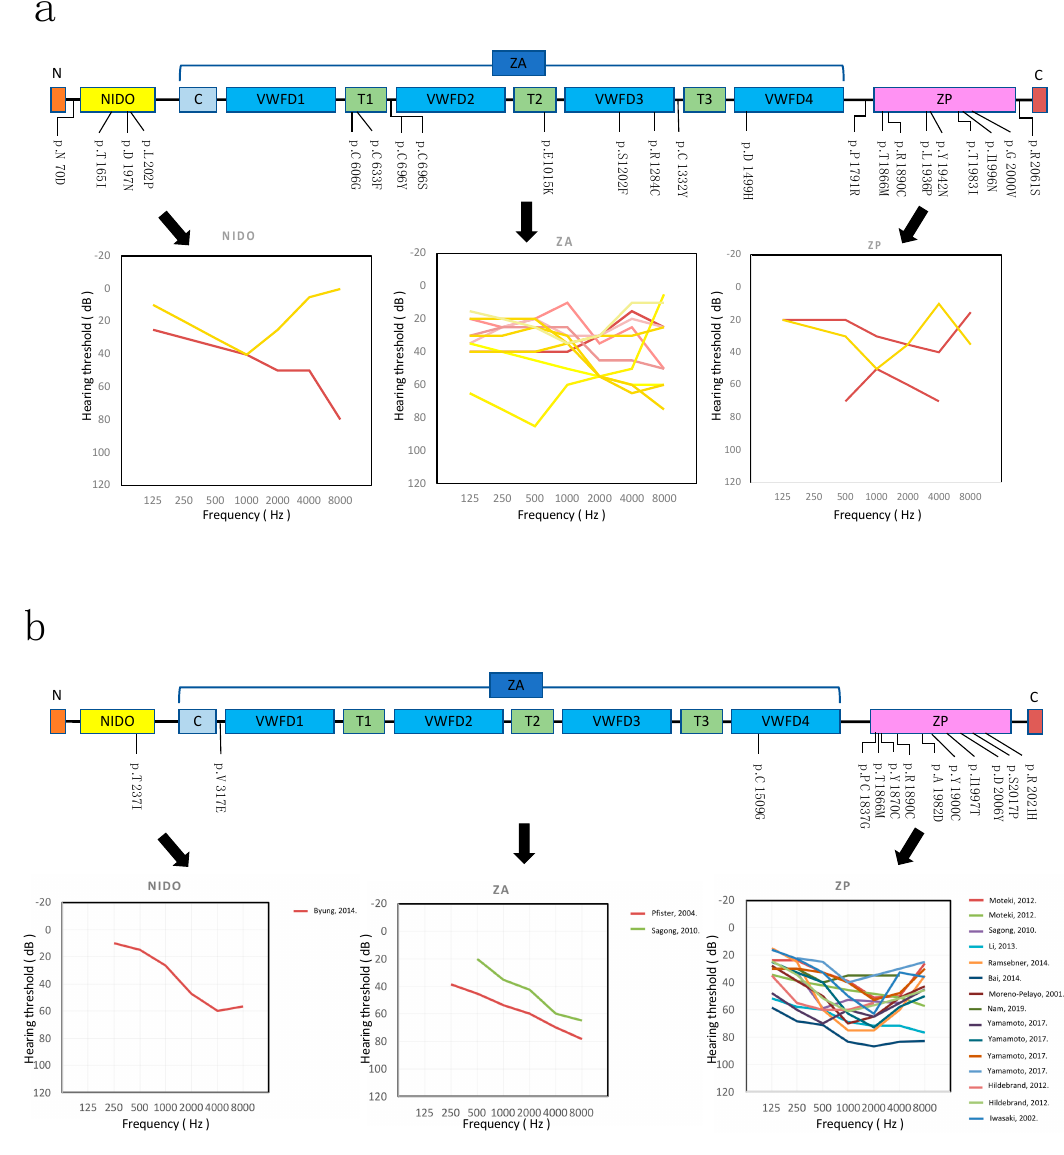
Figure 2. ( a ) Domain structure of α -tectorin and the overlapping audiograms from the better hearing ear for the patients with each domain variant. Yellow lines indicate the candidate VUS variants, and red lines indicate the likely pathogenic variants. ( b ) The overlapping audiograms for the patients that were reported variants of TECTA in previously. NIDO: Nidogen-like domain, ZA: Zonahesin-like domain, C: Von Willebrand factor C domain, T( n ): Trypsin inhibitor-like domain (number), VWD: Von Willebrand factor D domain, ZP: Zona pellucida domain.